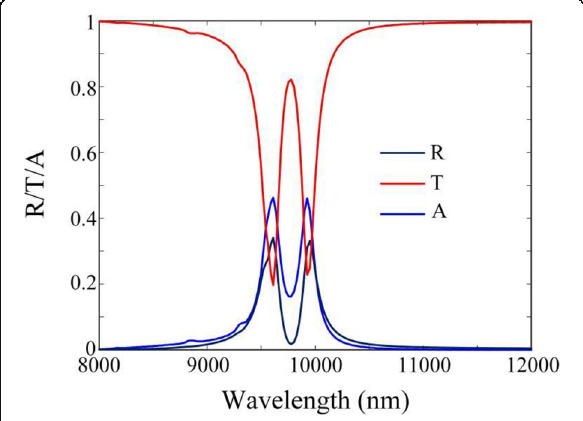
Fig. 2 The reflection (R), transmission (T), and absorption (A) spectra of the proposed graphene-based absorber with Fermi energies E f 1 = 0.66 eV and E f 2 = 0.31 eV under the illumination of only one incident beam I 1 in the z